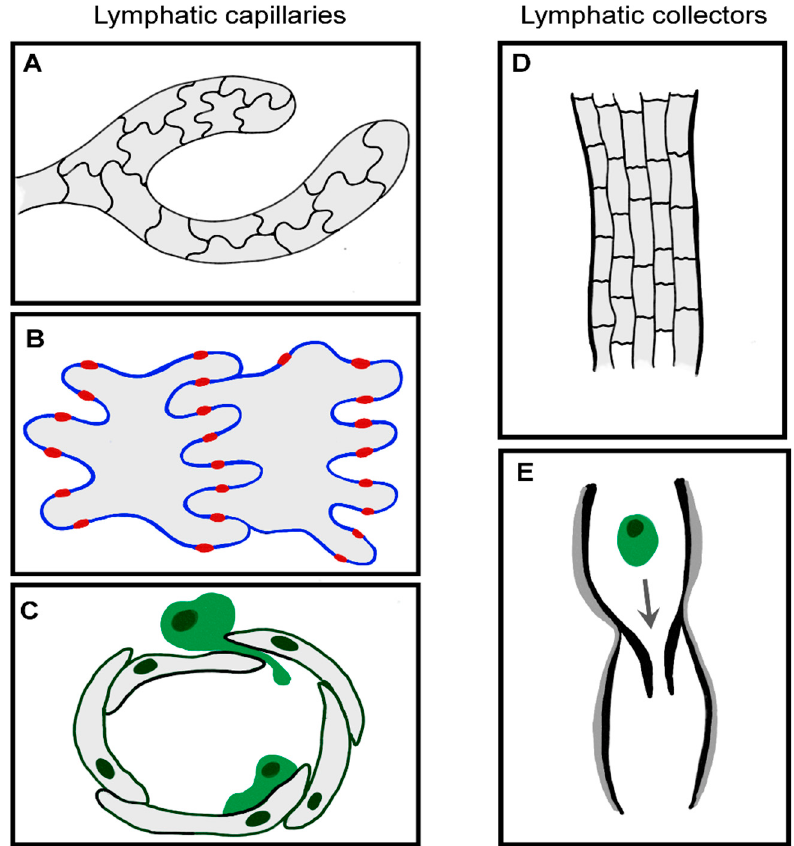
Figure 2. Functional specialization of LEC junctions. ( A–C ) Blind-ended capillaries of the initial lymphatics contain interdigitating oakleaf-shaped endothelial cells ( A ) held together with discontinuous button junctions, where adherens and tight junctional proteins provide the points of anchorage (red) in between flaps ( B ) through which fluid, macromolecules and migratory leukocytes enter without compromising the integrity of the endothelium ( C ) [60]. Once inside the vessel, leukocytes actively crawl along the luminal surface of endothelial cells, passing into pre-collector and collector vessels. ( D–E ) Collector vessels LECs are of a cuboidal shape, connected by continuous zipper junctions ( D ) and surrounded by basement membrane and smooth muscle cells (grey), with intraluminal valves to aid passive transit of migratory immune cells ( E ).